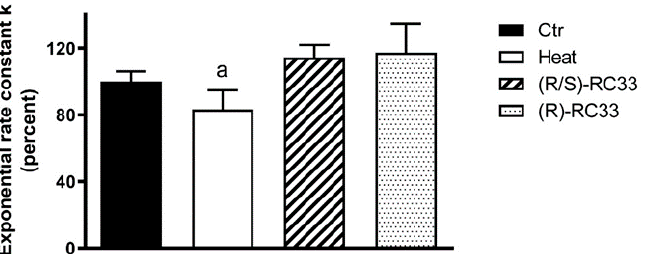
Figure 4. Effect of the RC33 stereochemistry on the water permeability of HeLa cells in heat-stress condition. Comparison between untreated cells (Controls, Ctr), cells treated at 42 °C for 3 h (heat- stressed, Heat), heat-stressed cells pre-treated with racemic ( R / S )-RC33 and enantiopure ( R )-RC33 at 20 µM final concentration. Bars represent the osmotic water permeability of HeLa cells expressed as percent of the exponential rate constant k. Values are means ± SD of 4–15 single shots (time course curves) for each of 4–6 different experiments. a, p < 0.05 vs. Ctr, ( R / S )-RC33, ( R )-RC33 (Repeated measures ANOVA, followed by Newman-Keuls’s Q test).